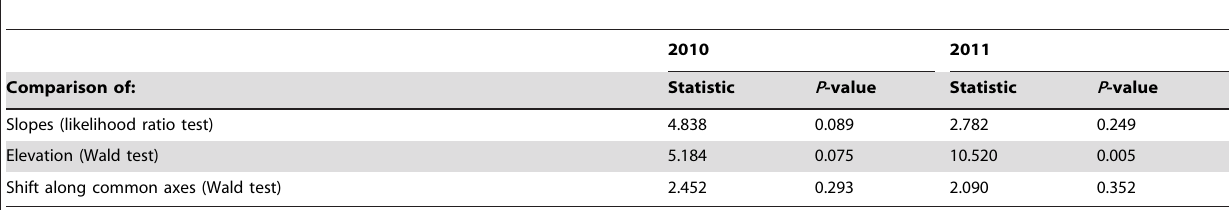
Table 4. Comparison of the allometric relation between trunk growth and area across